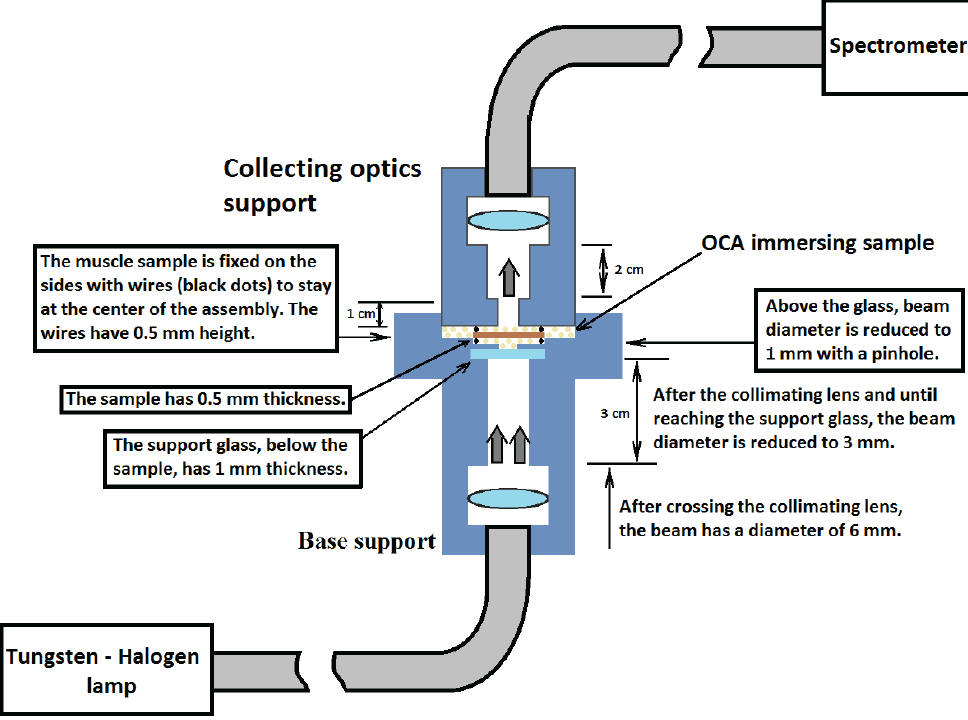
Fig. 1. Collimated transmittance measuring